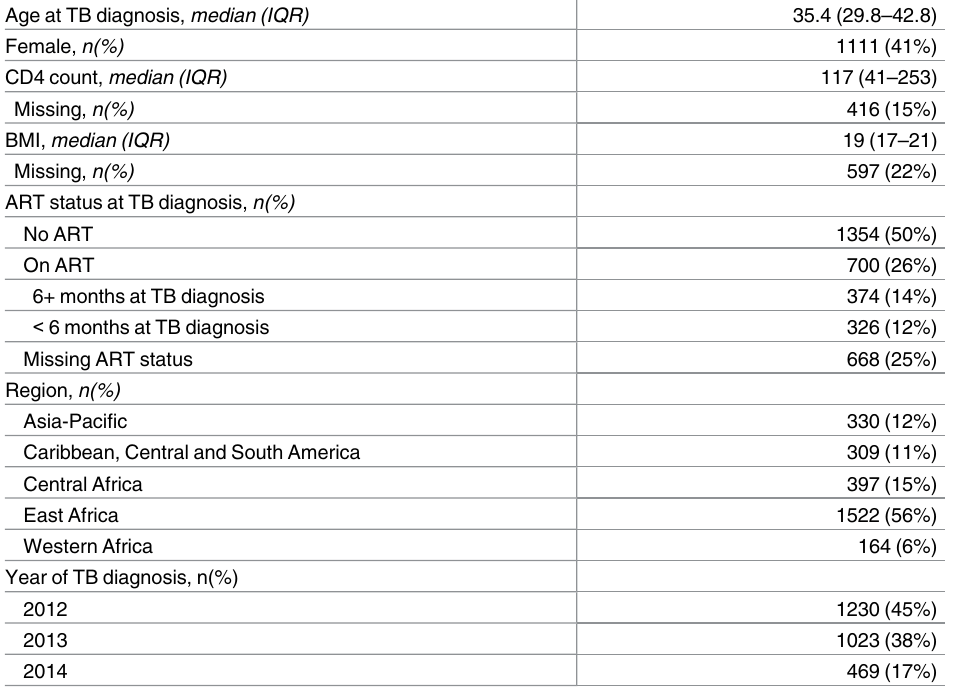
Table 1. Patient characteristics at time of TB diagnosis (n =